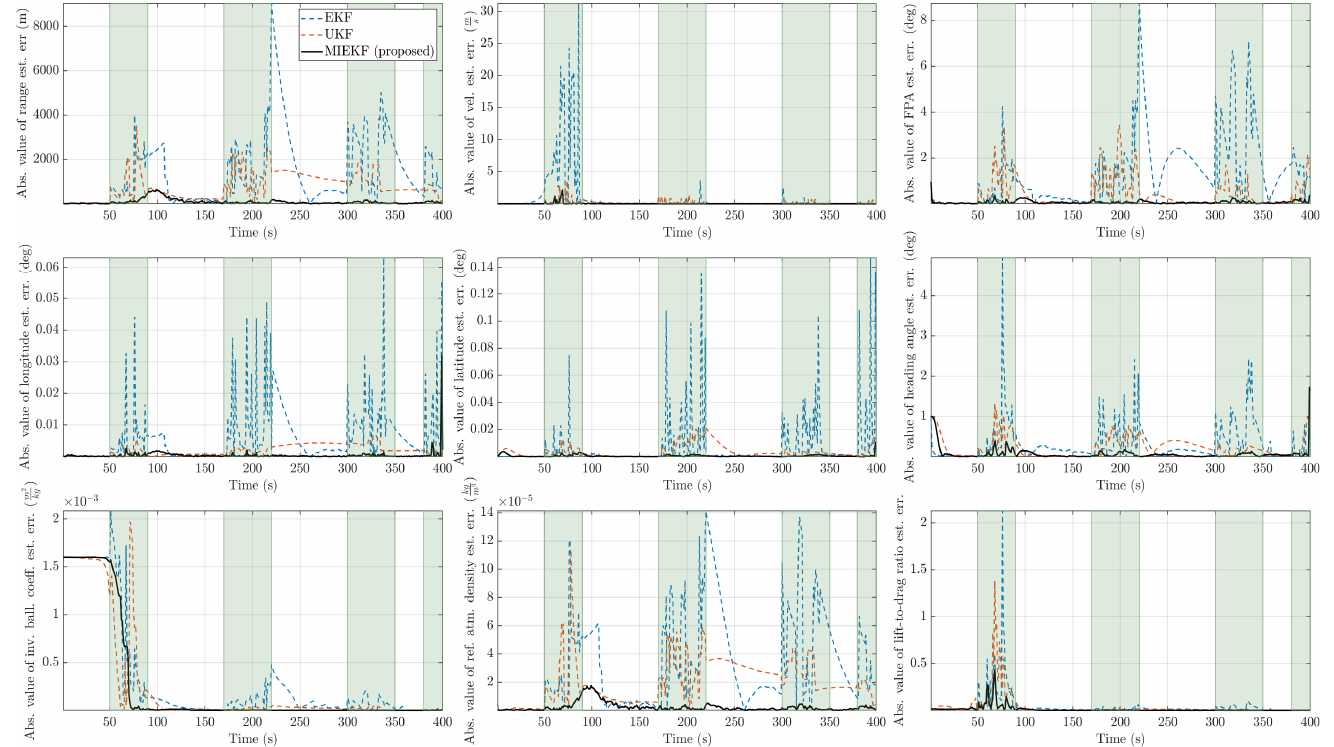
Figure 14. Absolute value of estimation errors with (cid:101) = 0.40 for the three candidate filters (the time intervals shaded in light green are intervals in which outliers are present).